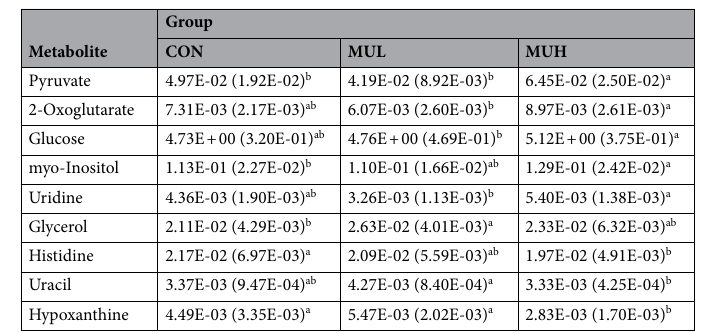
Table 5. Plasma metabolites showing significantly different concentrations (mmol/L) between CON, MUL, and MUH at slaughter (42 d) † . † Table entries are means and standard deviation in brackets. a, b Within a row, means with no common superscripts differ significantly ( p -value <